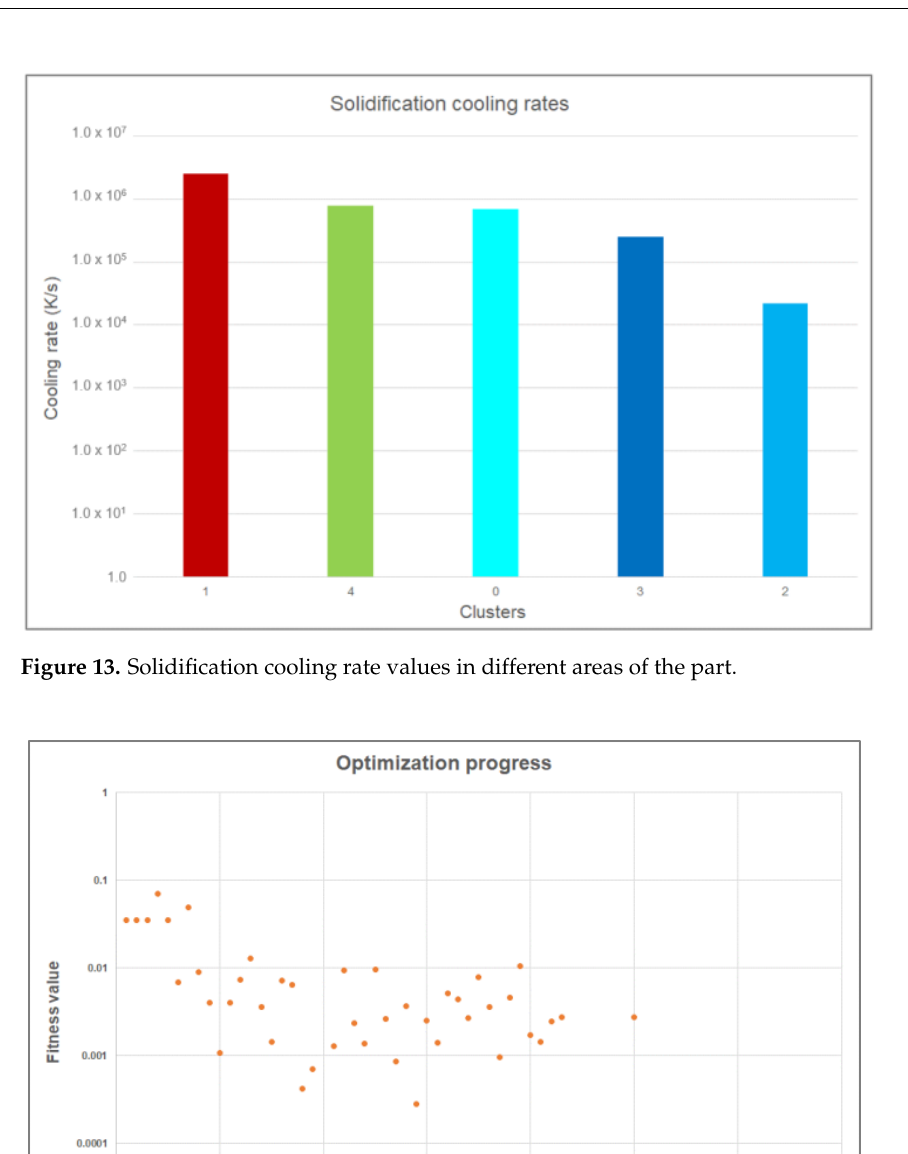
Figure 13. Solidification cooling rate values in different areas of the part.